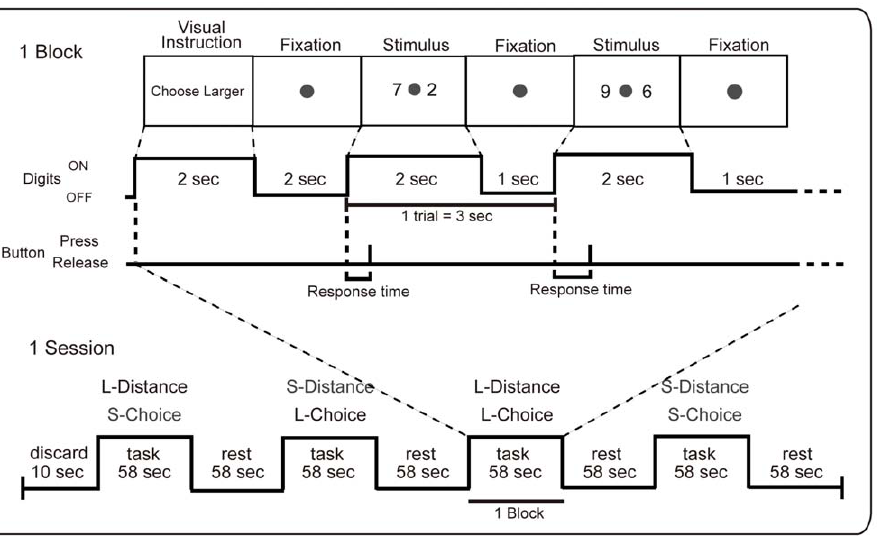
Figure 1. Task sequence of fMRI sessions. The session for each task included an instruction period, a resting period (in which only a fixation point was displayed), and a task period. Subjects were instructed to stare at a fixation point throughout the session and to select the correct digit as quickly as possible after a pair of digits was displayed. Instructions about which digit to select (larger/smaller) were visually presented before the beginning of each block (fMRI